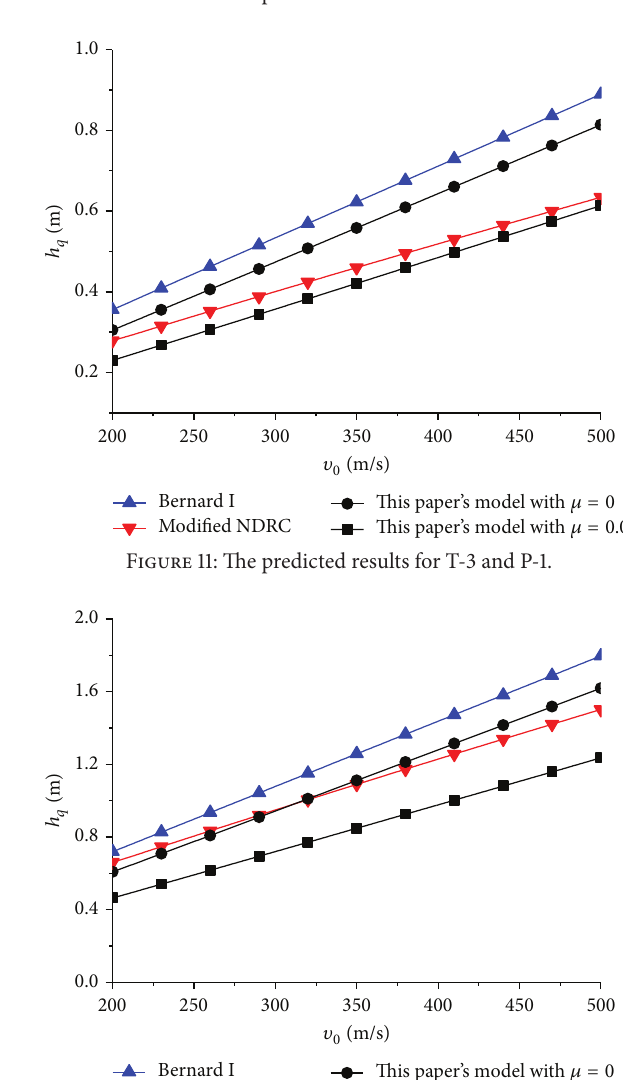
Figure 10: The predicted results for T-2 and P-2.